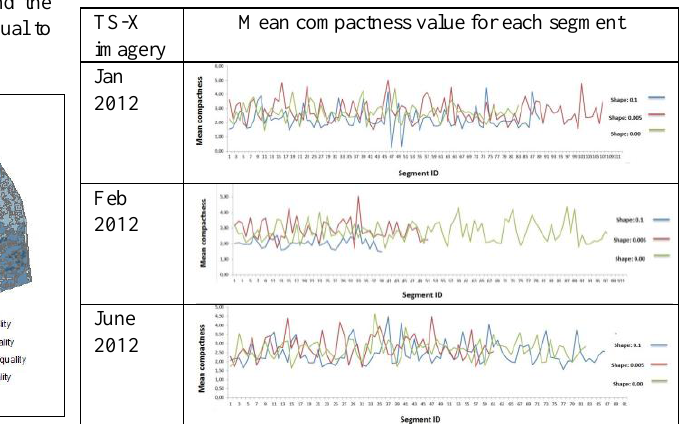
Table 2. Comparison of three different weightings of shape vs. colour on TS-X images acquired in five different months in 2012. The ESP tool was used to select the SP. The visual comparison of the results and the number of derived segments for each dataset reveals that using shape/colour with 0.005/0.995 or 0/1 results in more detailed segments compared to the shape/colour weighing of 0.1/0.9. Further comparison of the results was done using the compactness value of each segment (Table 3). Table 3 shows that setting the colour variance to 0.9 resulted in a more regular shape (mean compactness values between 2 to 3), whereas using 0.995 and 1 resulted in a more irregular shape (compactness values between 2 to 6). A compactness value of 1 indicates that the shape is close to a circle, thus higher compactness values may potentially indicate more complex natural